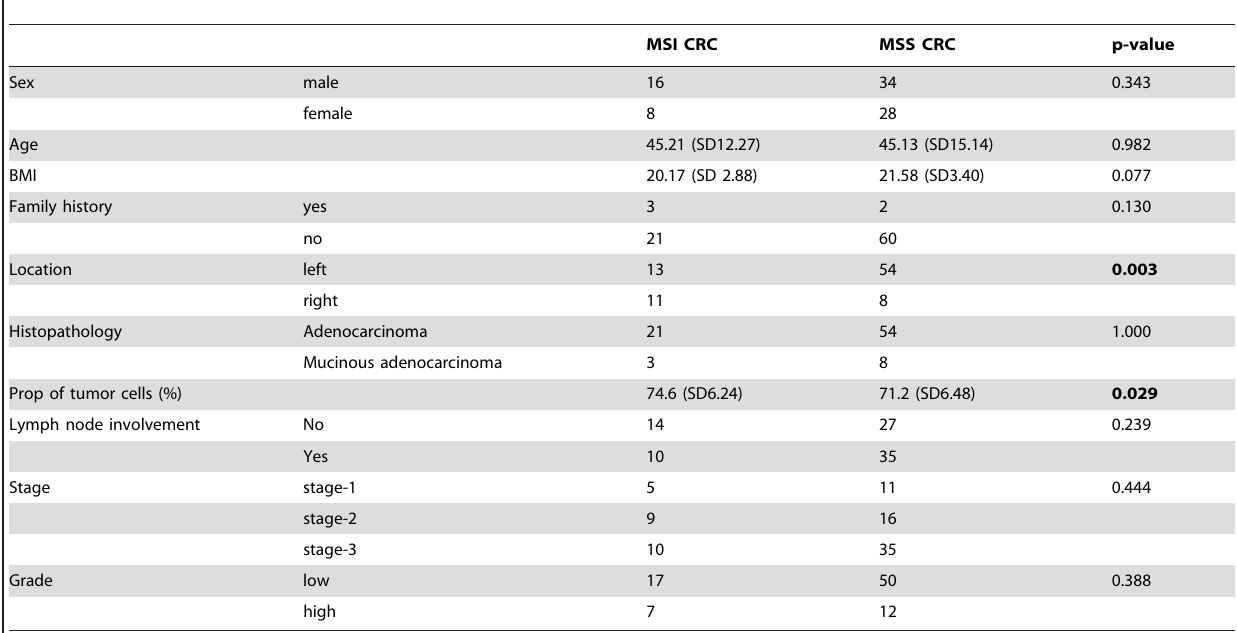
Table 1. Patient and tumor characteristics of 86 cases of CRC stratified by MSI status.